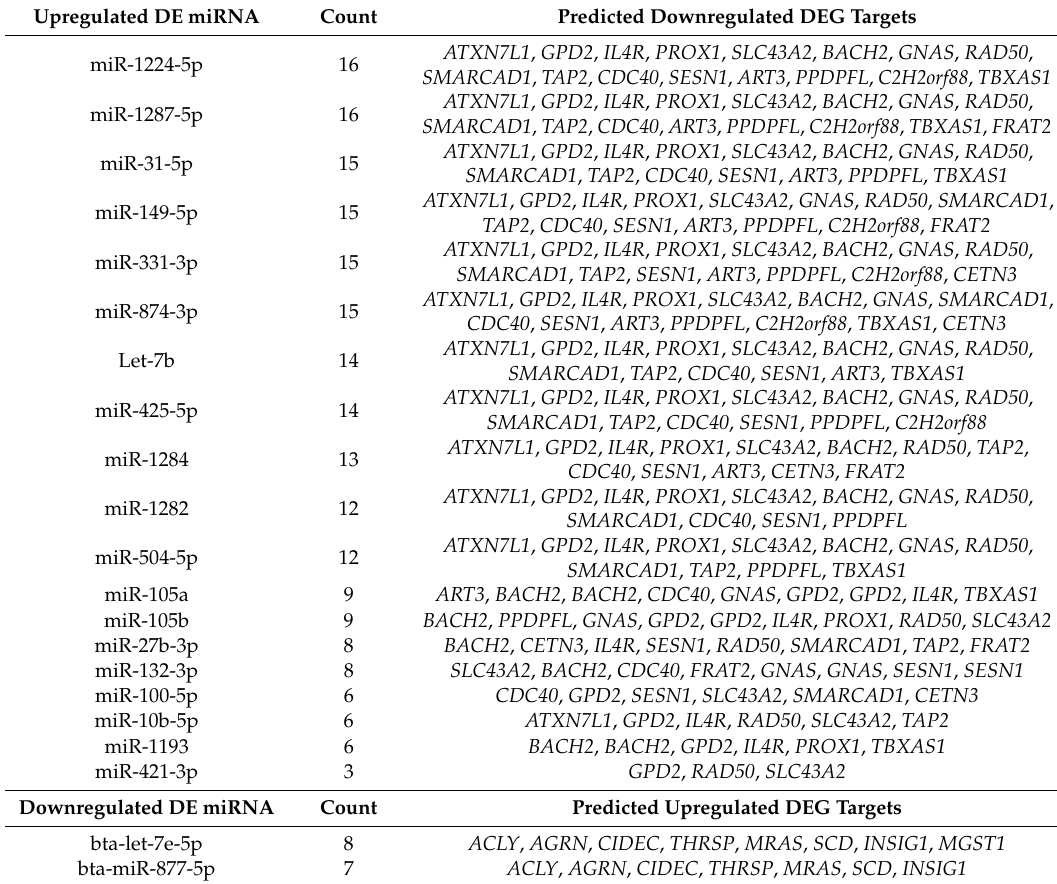
Table 2. Predicted DE miRNA gene targets from di ff erentially expressed genes (DEGs) with functions associated with lipid metabolism and fat